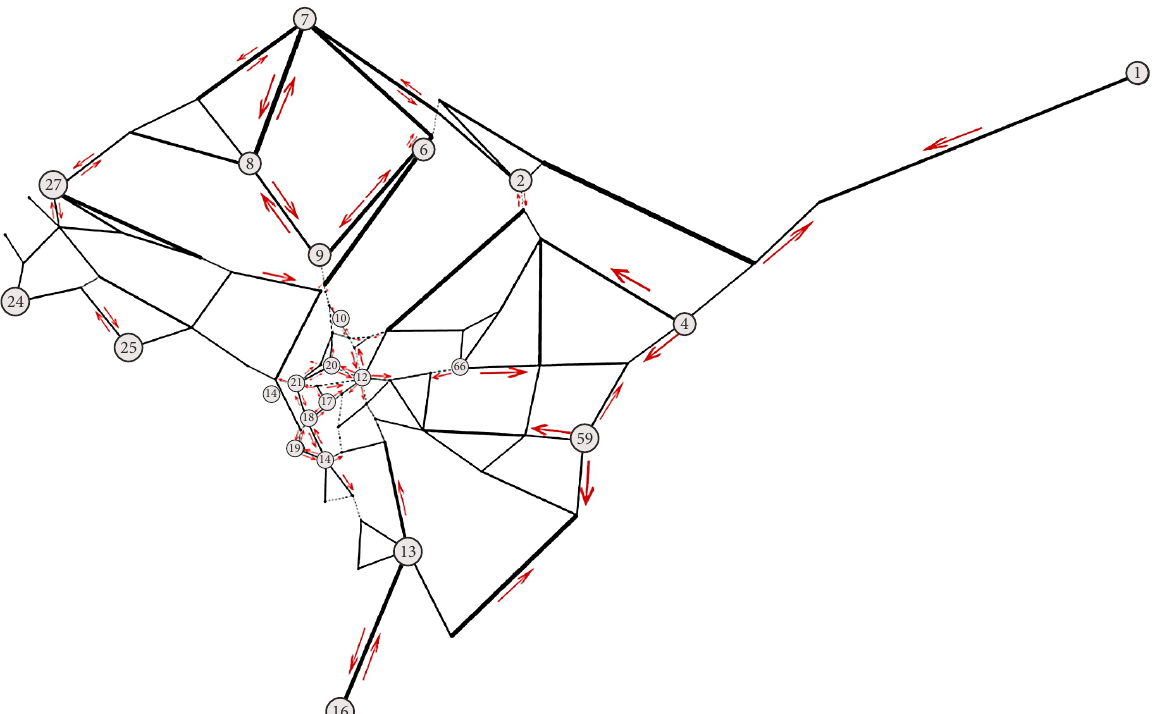
Figure 8. Isfahan’s intercity road network marking the links selected for conducting